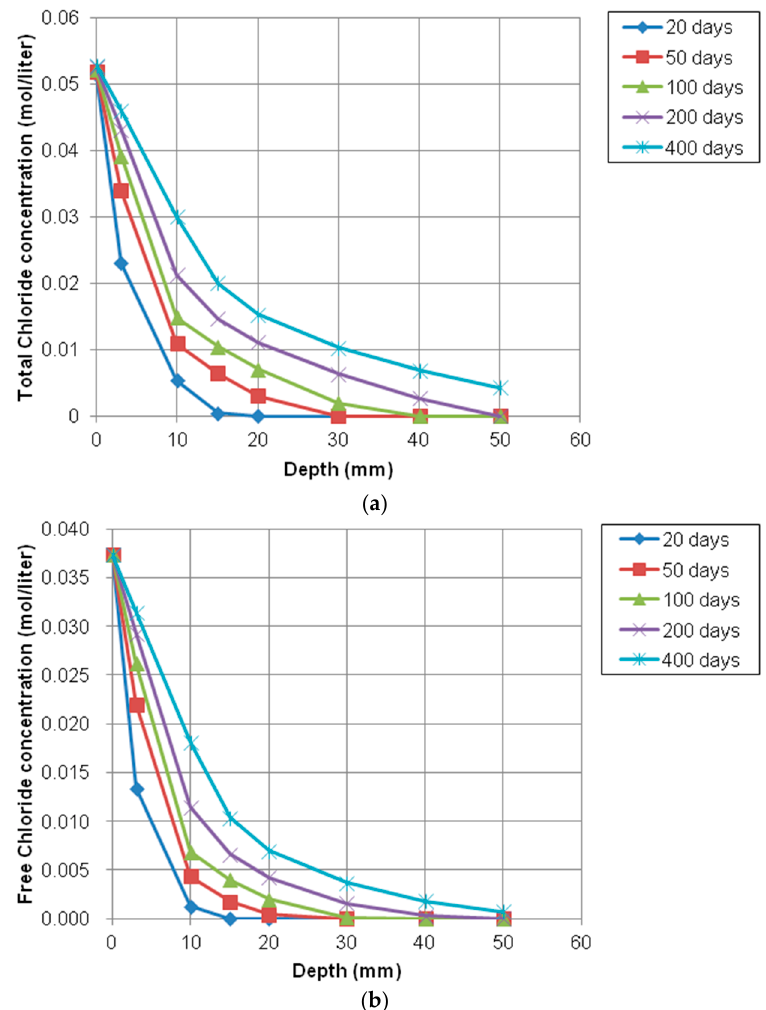
Figure 11. Profile of chloride concentration at different depth over time. ( a ) Total chloride concentration profile over time; ( b ) Free chloride concentration profile over time.